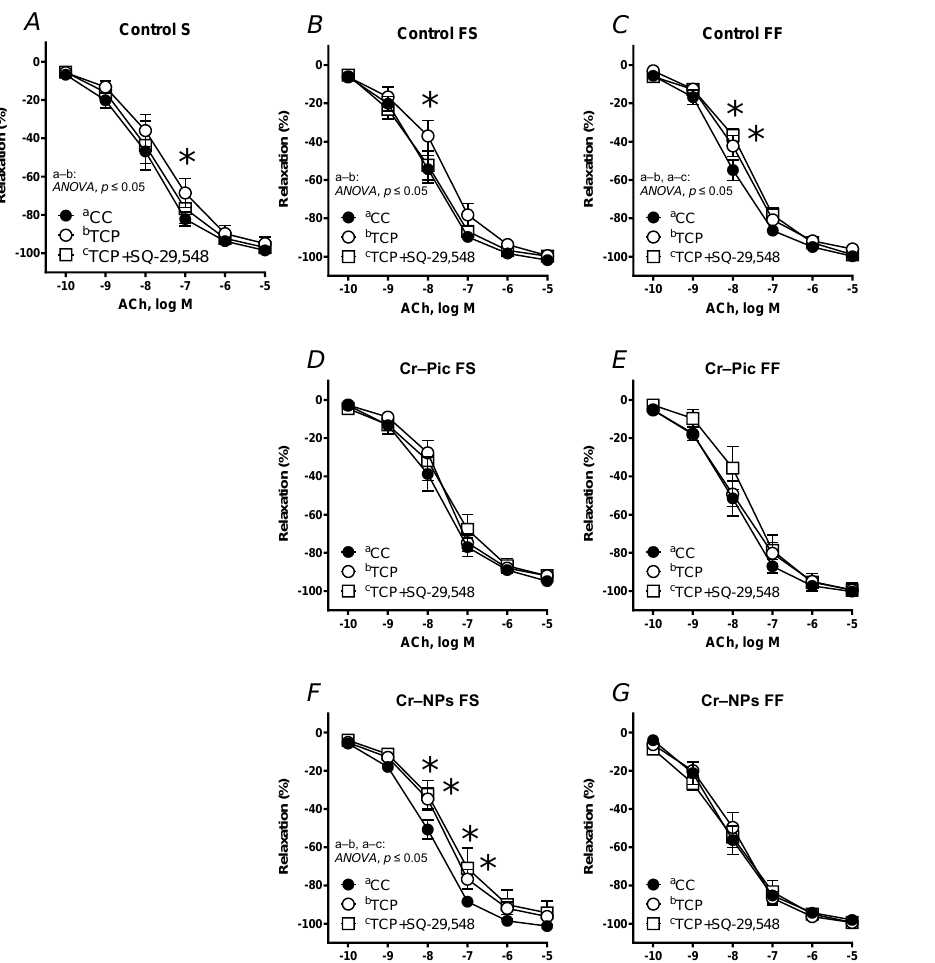
Figure 8. Effects of TCP (10 µM) and TCP (10 µM) plus SQ-29,548 (1 µM) on the concentration – response curves to acetylcholine (ACh) in aortic rings from the following groups of rats: control S